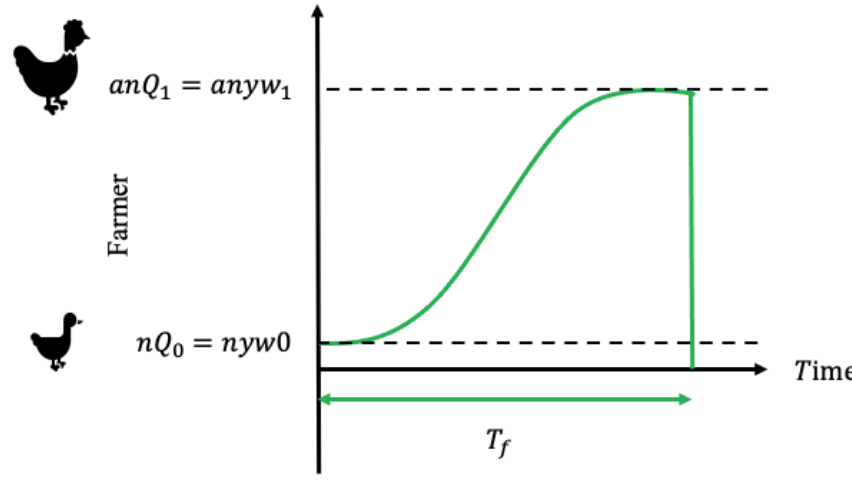
Figure 4. Farmer ´ s inventory